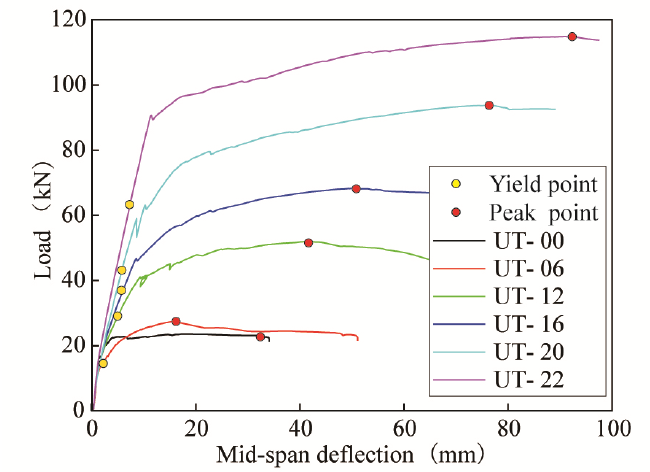
Figure 10. Load vs. mid-span deflection curves.